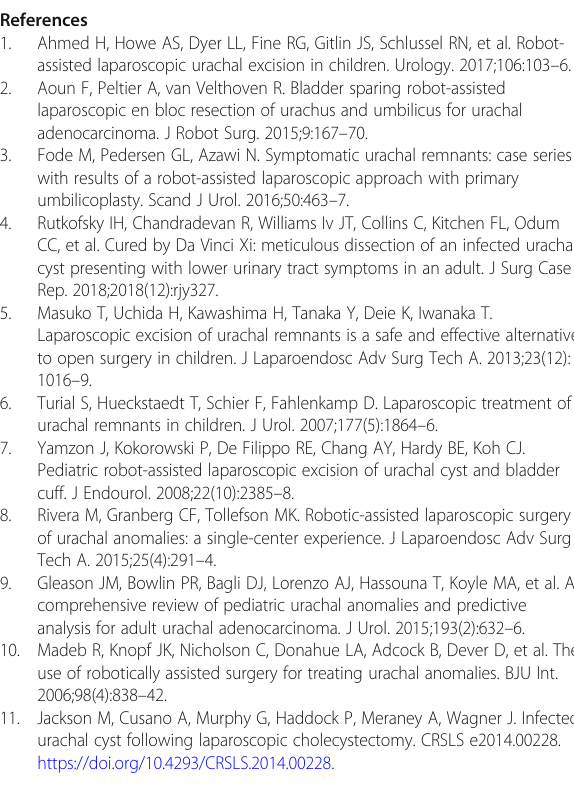
Abbreviation CRP: C-reactive